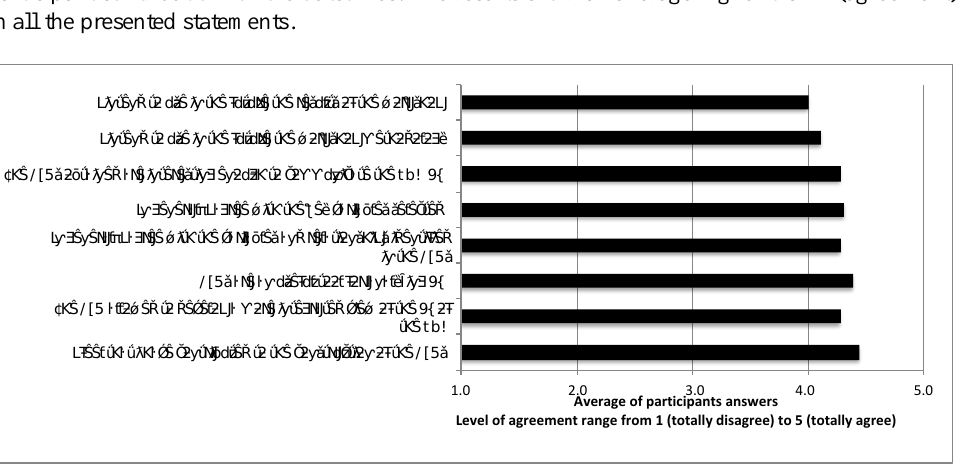
Fig. 6. Evaluation of outcomes from the participatory systems mapping process (average of selected evaluation statements). The majority of participants (87.5 %) stated that the workshop was worth the time spent and only 12.5 % answered “in some way”, while none of the participants replied negatively to this question. Regarding the positive and negative aspects of the workshop, the comments collected can be organized into broader categories. The identified negative aspects were mainly